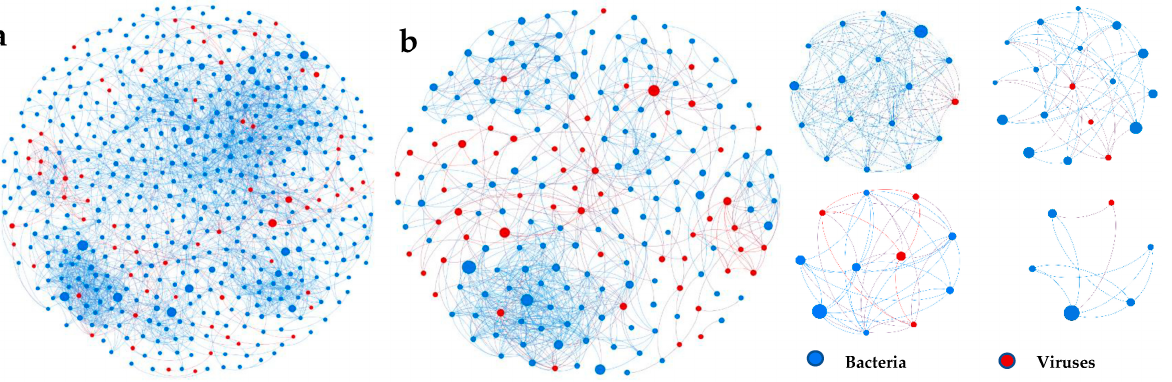
Figure 5. The relationship between bacteria and phages in the six viromes. ( a ) Proportion of bacterial genera and phage species that have a clear relationship of infection based on Virus–host database.